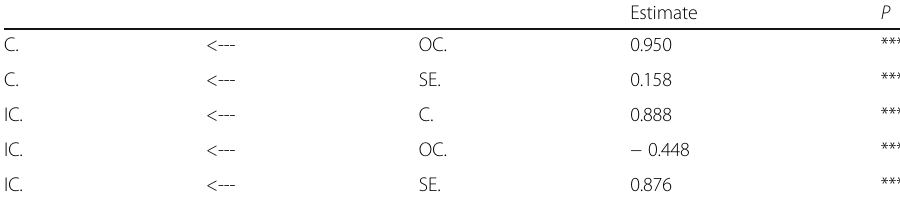
Table 3 Standardized regression